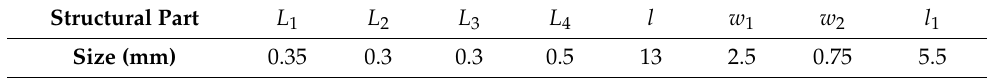
Table 1. The specific dimensions of the final deformation mechanics and driver. Structural